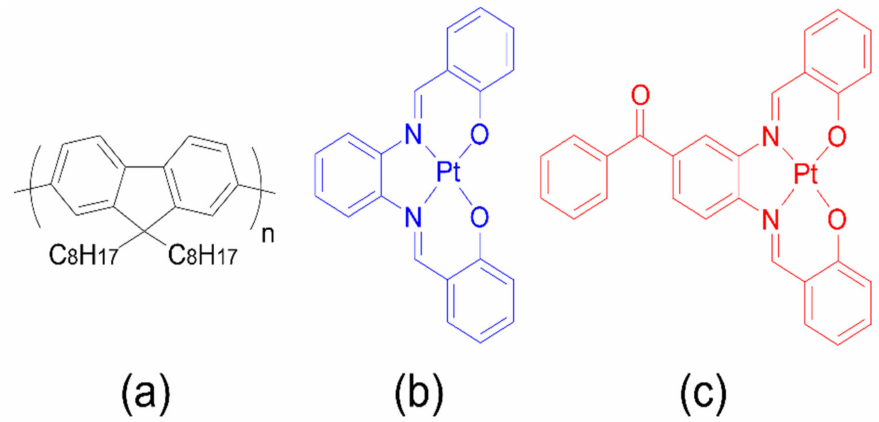
Figure 1. Molecular structures of PFO ( a ), [Pt(salophen)] ( b ) and [Pt(sal-3,4-ben)] ( c ) organic semicon- ducting materials.